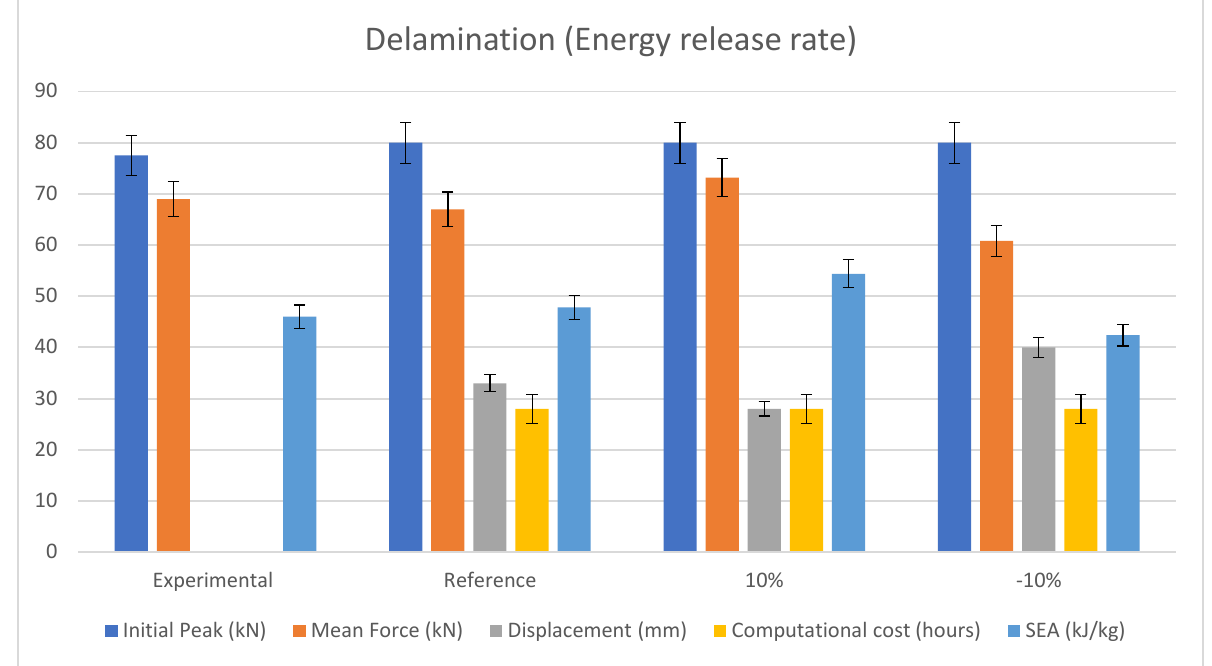
Figure 19. Delamination resistance comparison [66].